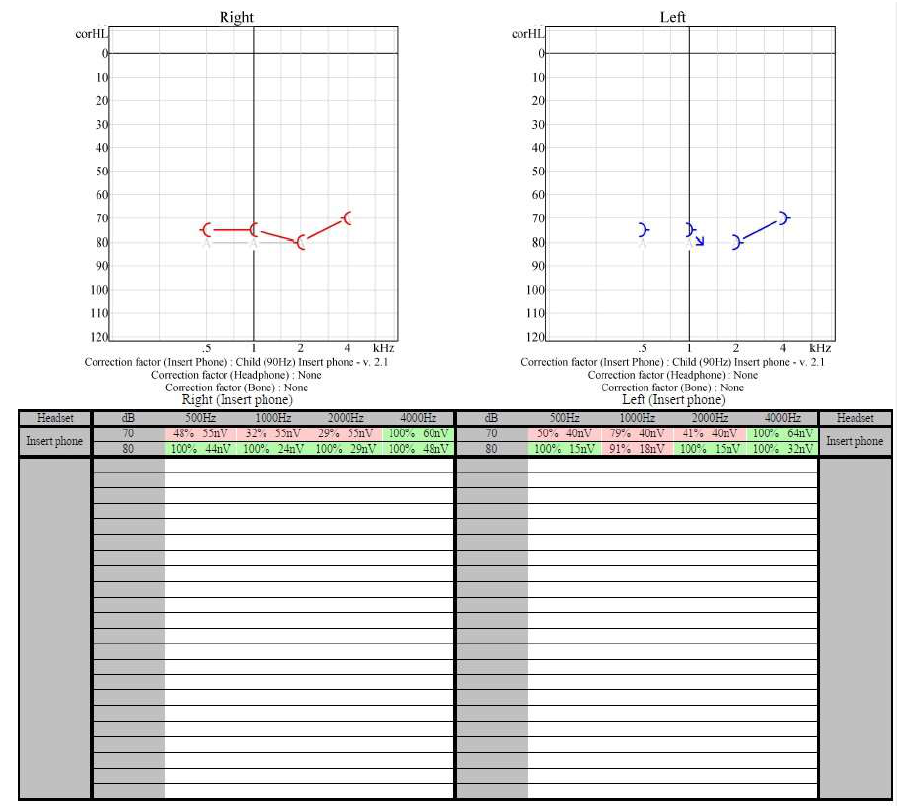
Figure 1. Audiometry Steady State Response results for Case 1 (Severe bilateral sensorineural hearing loss).